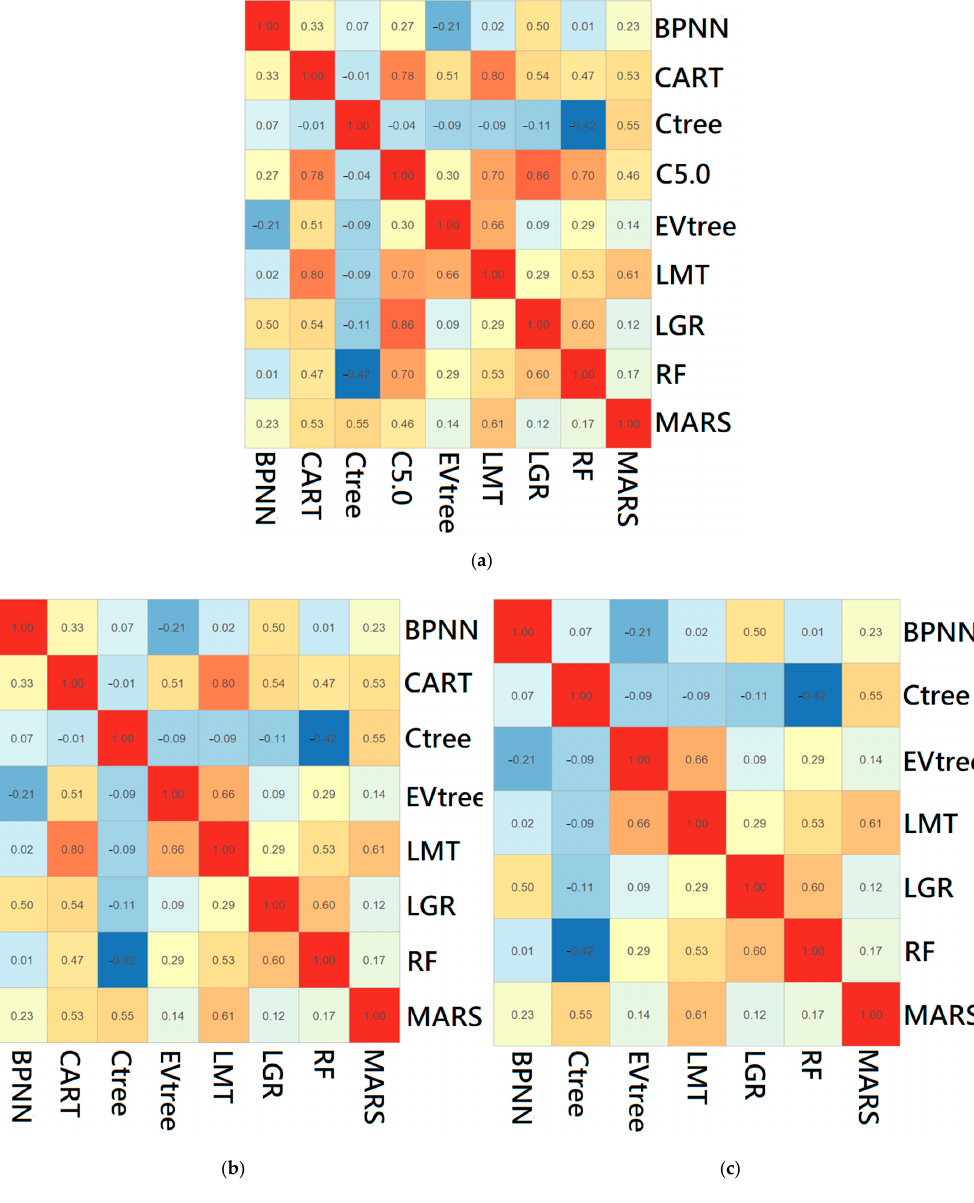
Figure 2. Inter-classifier correlations among base classifiers during training stage: ( a ) initial inter-classifier correlation matrix; ( b ) first iteration; ( c ) second iteration. Warm and cold color mean positive and negative inter-correlation, respectively. The darker the color, the stronger the degree.